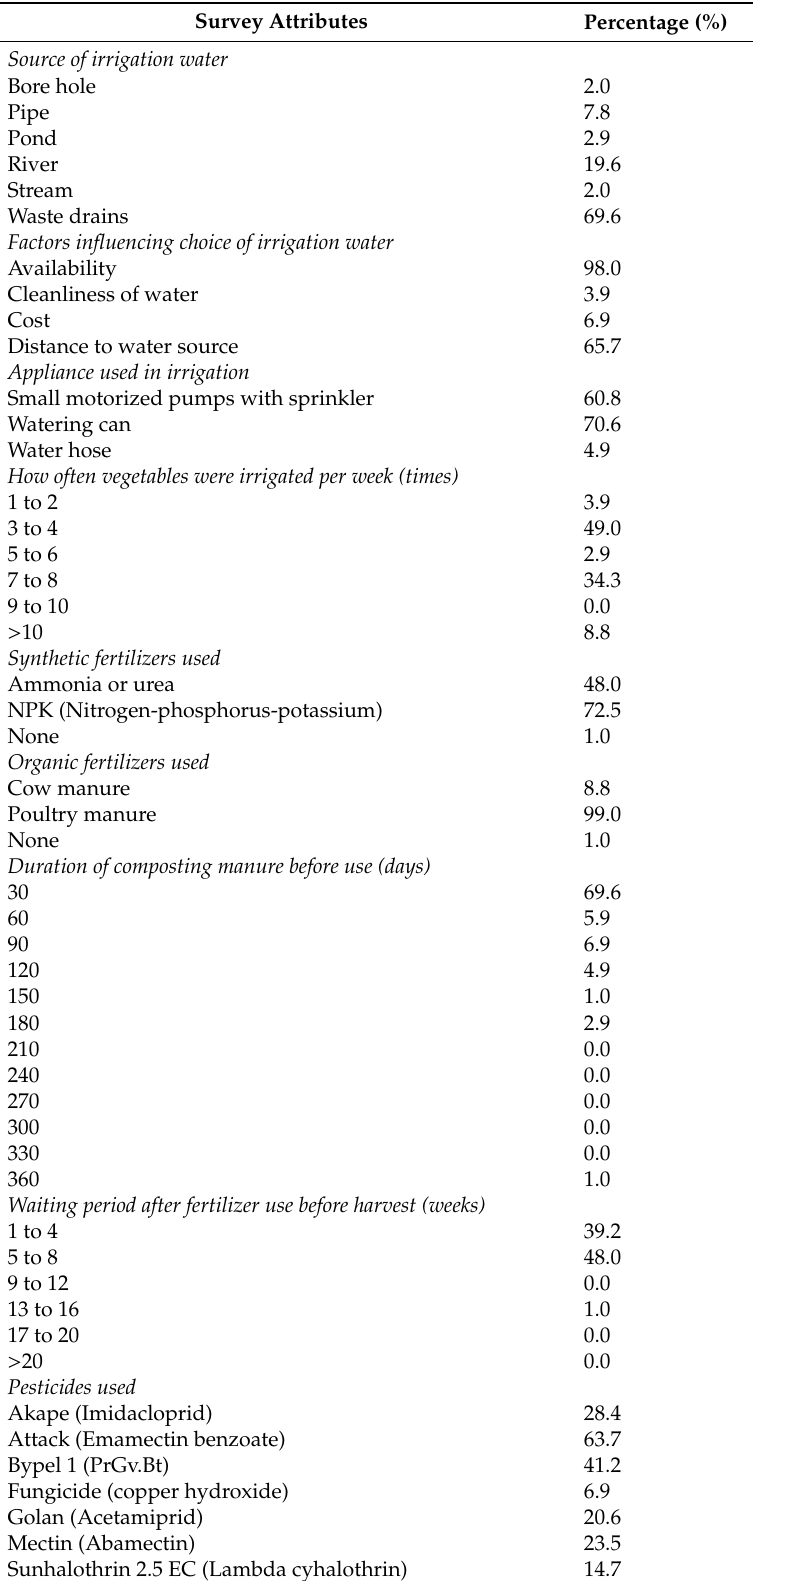
Table 4. Irrigation, fertilizer and pesticide use practices of participating vegetable farms in Accra, Ghana. Survey